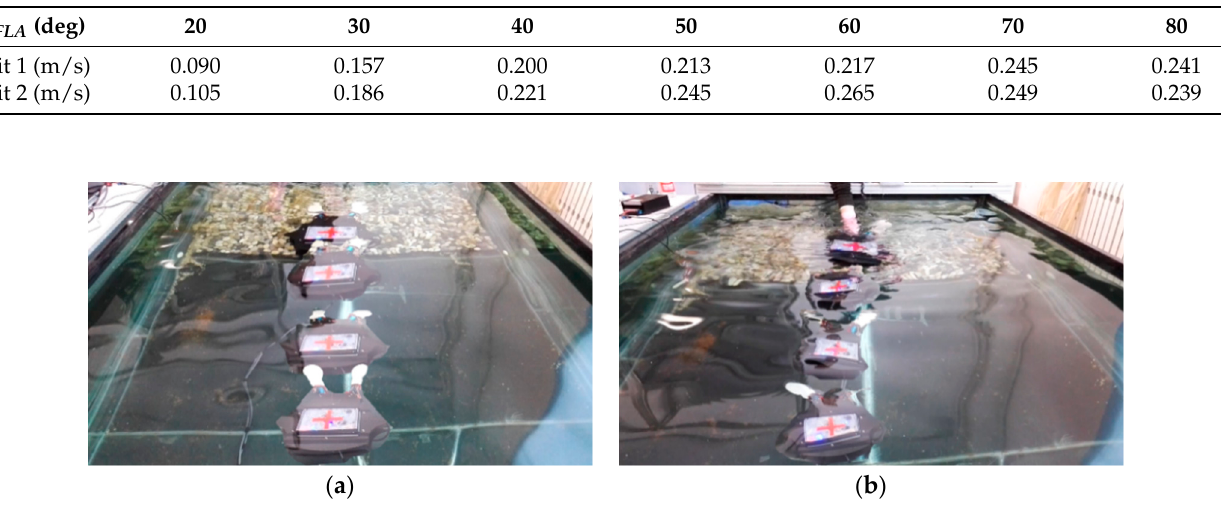
Table 4. The motion performance indexes of the robot .